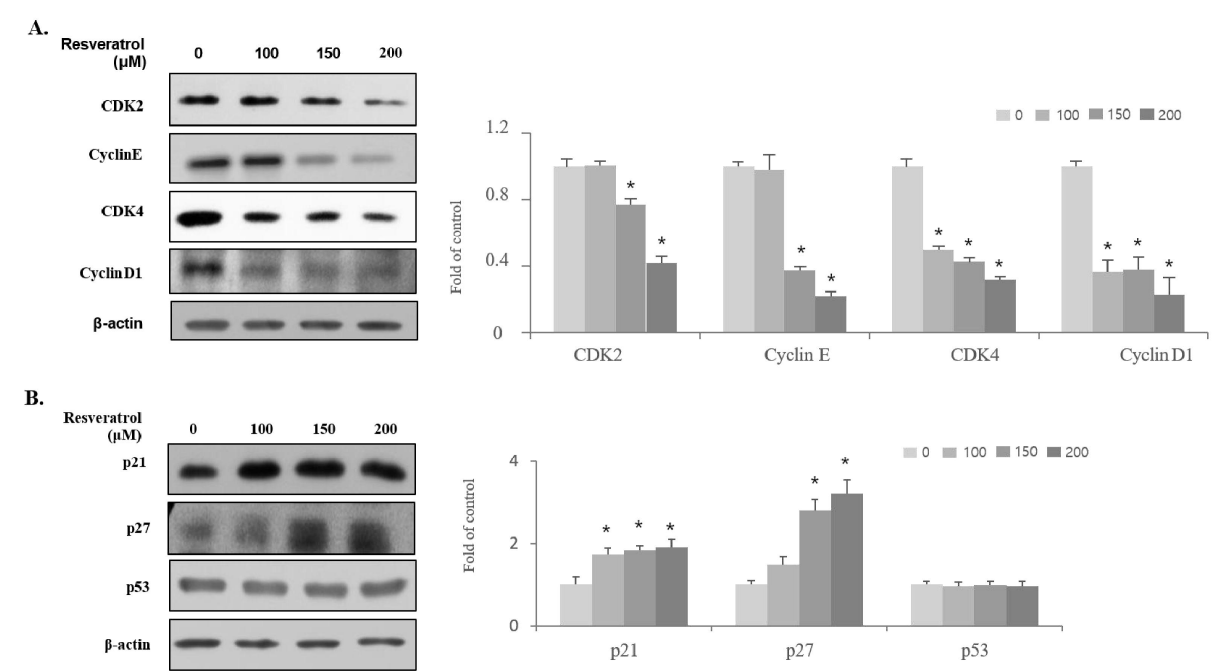
Figure 4. Regulation of cell-cycle-related protein expression in WPMY-1 cells by resveratrol treatment. Cells were incubated with resveratrol for 24 h at the indicated concentrations. ( A , B ) Changes in regulatory proteins involved in cell cycle progression were analyzed by immunoblot. β-actin was used as a housekeeping protein in this experiment. The data are expressed as mean ± SD as a result of three independent experiments depending on the resveratrol concentration (* p < 0.05).